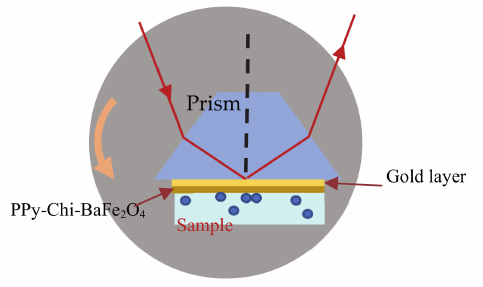
Figure 1. The surface plasmon resonance (SPR) setup to test the PPy–Chi–BaFe 2 O 4 sensing layer